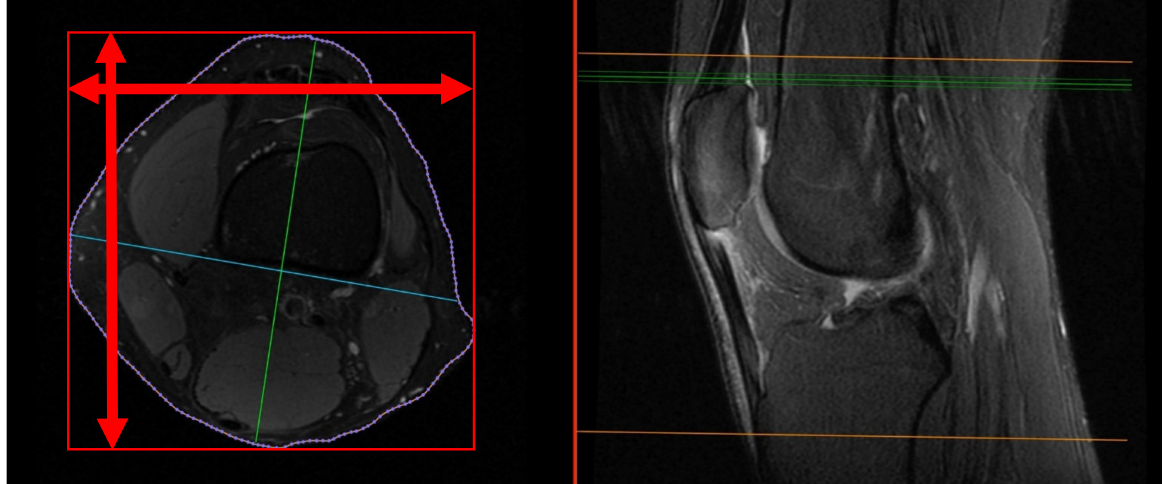
Figure 2. Knee diameters were measured on axial PD-weighted images at the exact level of the patella upper pole, indicated by the green line on the right image. Radiologists measured strictly antero-posterior = vertical and medio-lateral = horizontal (red arrows). The maximal diameter of the knee was not measured (green line on left